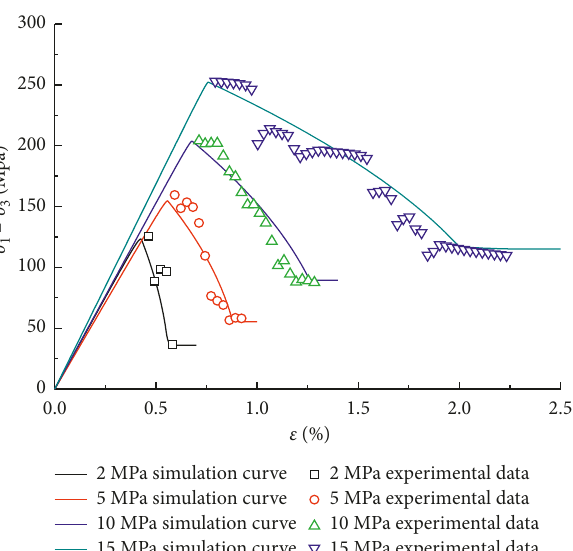
Figure 12: Comparison between Hegang granite triaxial com- pression test data and numerical simulation curves.